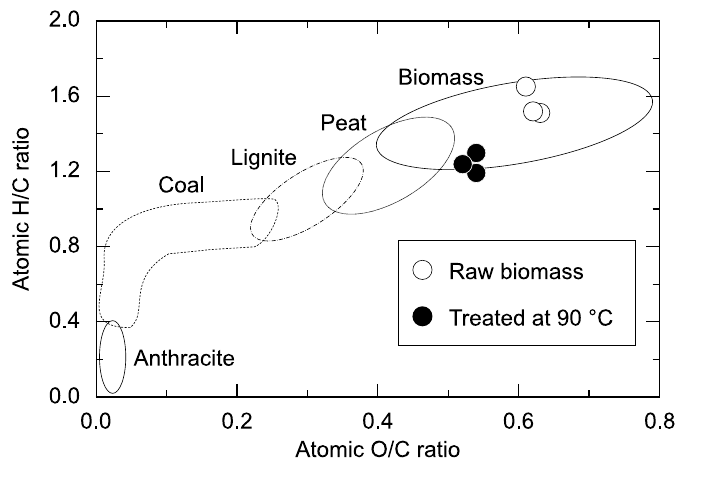
Fig 6. van Krevelen diagram of raw manure and manure treated at 90 ˚C.